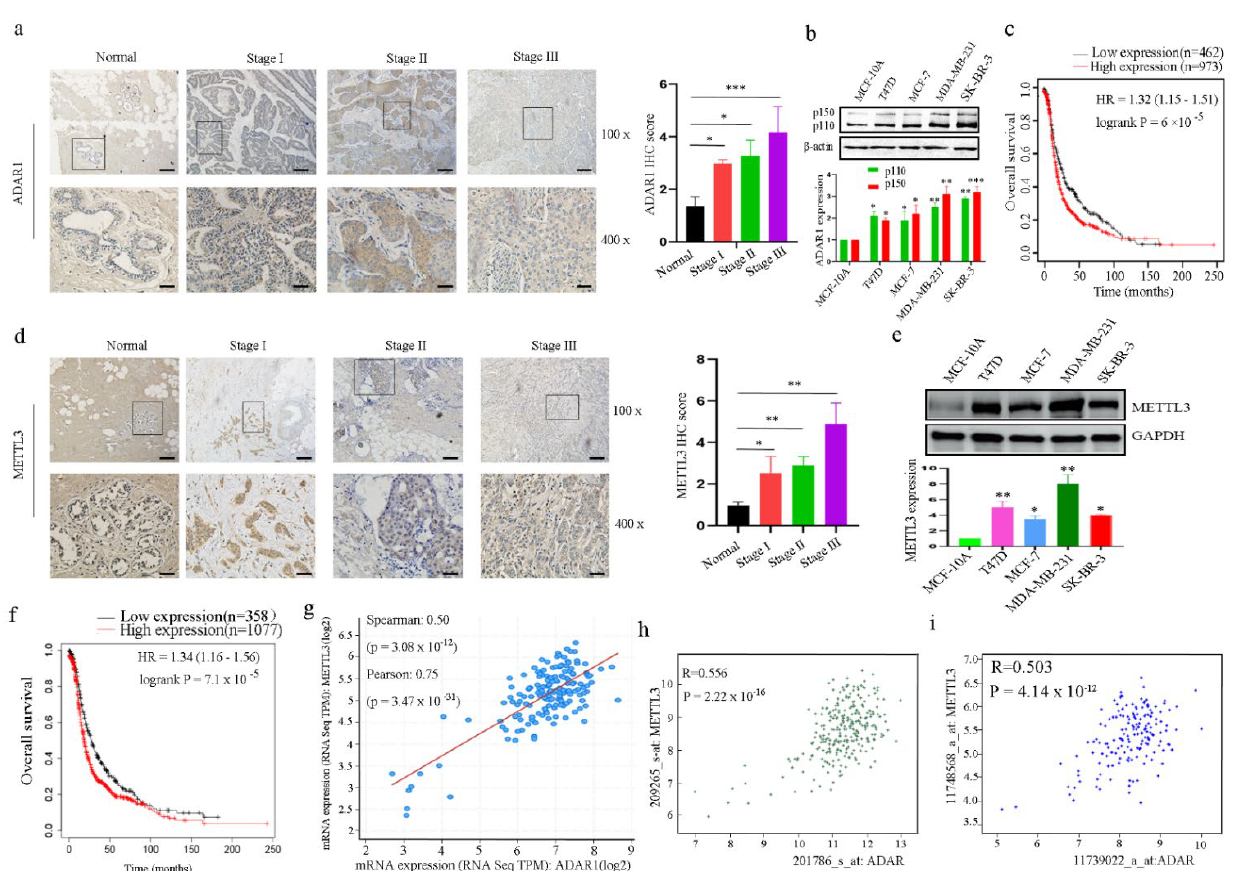
Figure 1. Both ADAR1 and METTL3 are upregulated in breast cancer tissues and cell lines. ( a ) Representative IHC staining micrographs of ADAR1 in breast cancer patients at different stages (magnification 100×, scale bar = 100 μm; magnification 400×, scale bar = 25 μm). Data are represented as means ± SD. * p < 0.05, *** p < 0.001. ( b ) ADAR1 protein levels assessed by Western blot were upregulated in breast cancer cell lines compared to normal human mammary epithelial cell line (MCF-10A). ( c ) Kaplan–Meier survival curves of ADAR1 in breast cancer patients (n = 1435). The median expression level was used as a cut-off to divide patients into low and high groups. ( d ) Representative IHC staining micrographs of METTL3 in breast cancer patients at different stages (magnification 100×, scale bar = 100 μm; magnification 400×, scale bar = 25 μm). Data are represented as means ± SD. * p < 0.05, ** p < 0.01. ( e ) METTL3 protein levels assessed by Western blot were upregulated in breast cancer cell lines compared to MCF-10A. ( f ) Kaplan–Meier survival curves of METTL3 in breast cancer patients (n = 1435). ( g – i ) The mRNA expression correlation of ADAR1 with METTL3 in three independent datasets.